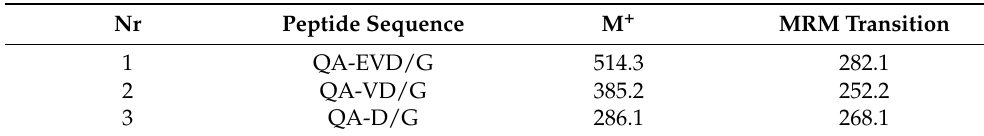
Table 1. Mass spectrometry data of the investigated peptides with the QA-EVD/G, QA-VD/G and QA-D/G sequences.